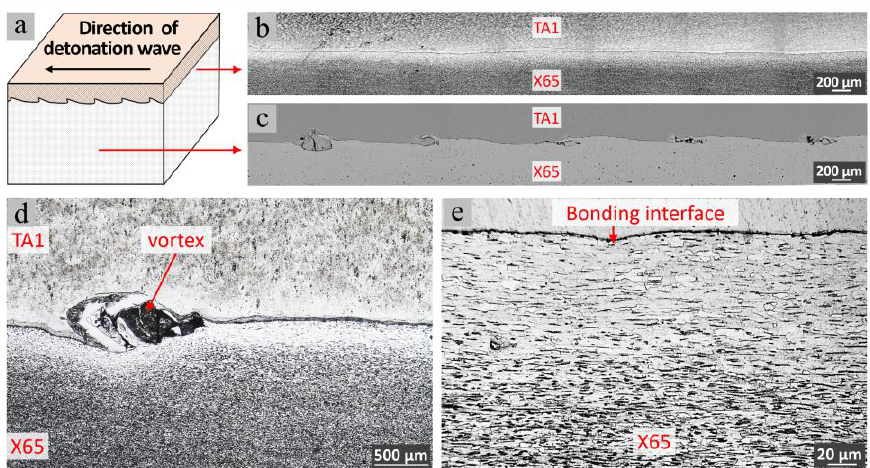
Figure 5. The microstructure observed on the cross sections of TA1/X65 clad plate: ( a ) different interface; ( b ) cross section was perpendicular to the direction of detonation wave propagation; ( c ) cross section was parallel to the direction of detonation wave propagation; ( d ) vortex; and ( e ) bonding interfacial.